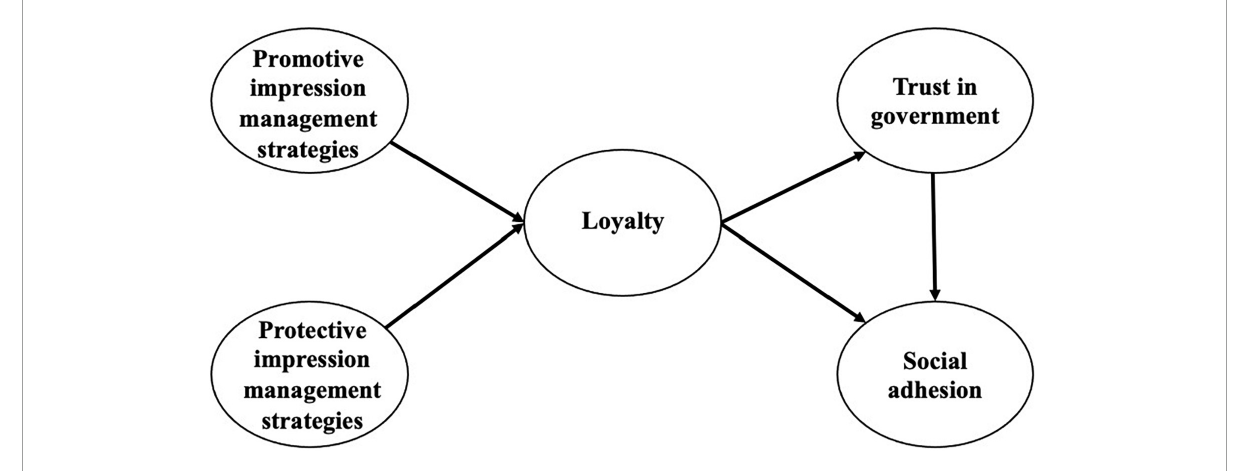
FIGURE1 Research theoretical